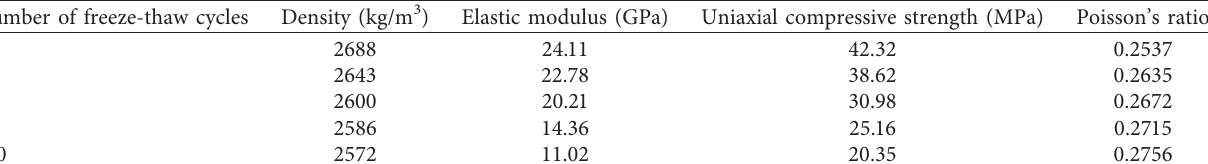
Table 1: Physical and static parameters of sandstone under freeze-thaw cycle.